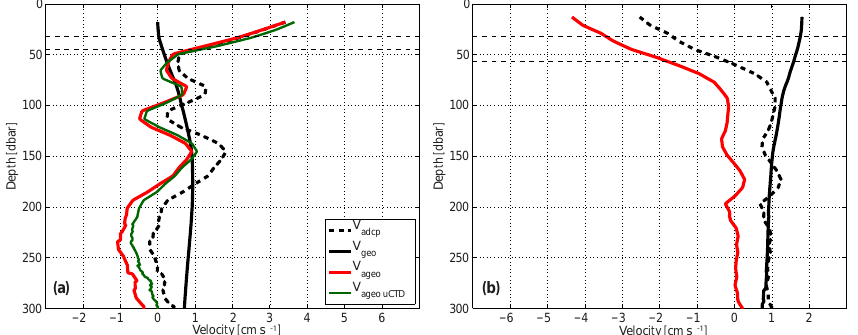
Figure 3. Section-averaged cross-track velocity profiles at (a) 14.5 ◦ N and (b) 11 ◦ S. In (a) , the solid red curve and the solid black curve are the ageostrophic and geostrophic velocity calculated from the CTD data, respectively. The dark green curve is the ageostrophic velocity profile based only on the uCTD data. In (b) , the solid red curve and solid black curve are the ageostrophic and geostrophic velocity calculated from the combination of the CTD/uCTD data, respectively. The dashed black curve is the ADCP velocity. The upper horizontal dashed line denotes the basin-wide averaged MLD and the lower one denotes the basin-wide averaged TTP depth.